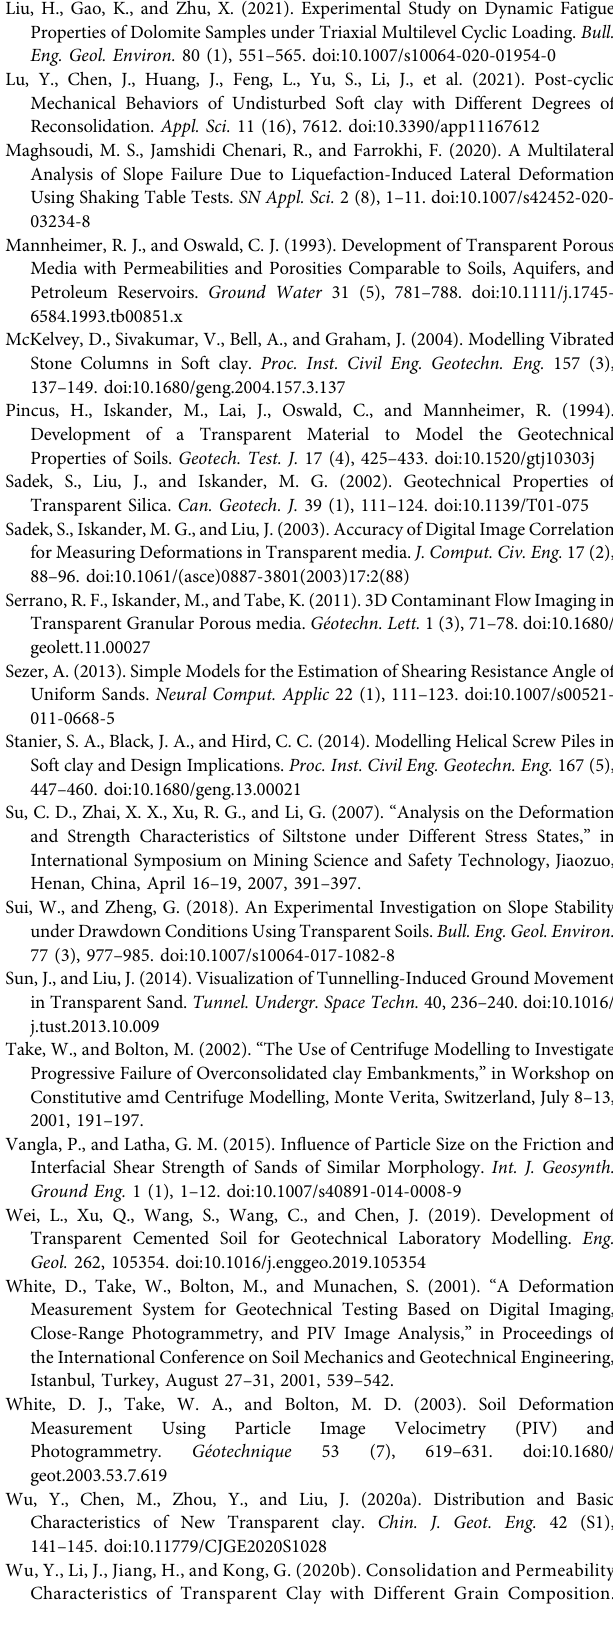
Using Shaking Table Tests. SN Appl. Sci. 2 (8), 1 – 11. doi:10.1007/s42452-020-